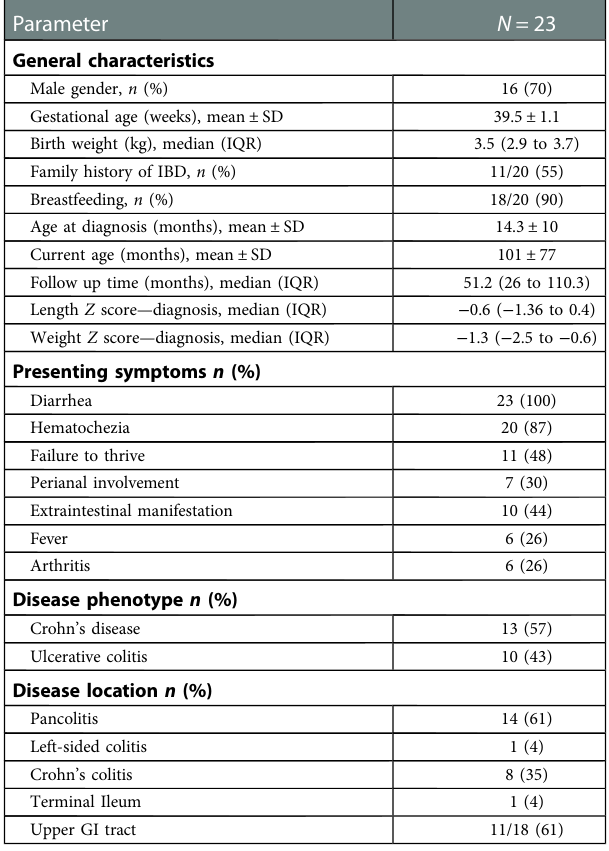
TABLE 1 Demographic and clinical characteristics of children with infantile-onset in fl ammatory bowel